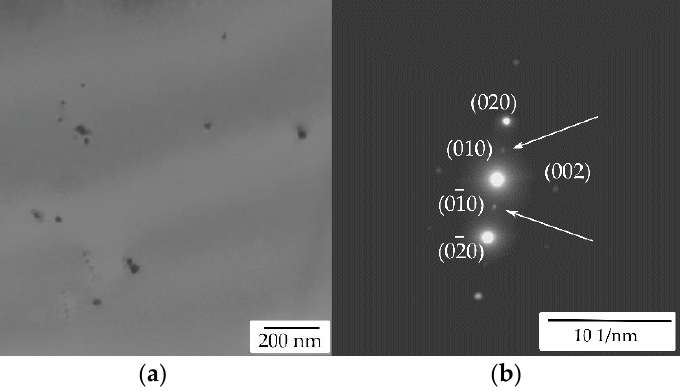
Figure 14. TEM image of the AlYb HT alloy after isochronal treatment up to 510 °C — see ( a ) secondary Al 3 Yb particles with different sizes and ( b ) selected area diffraction near [100] Al pole with spots from the L1 2 structure.